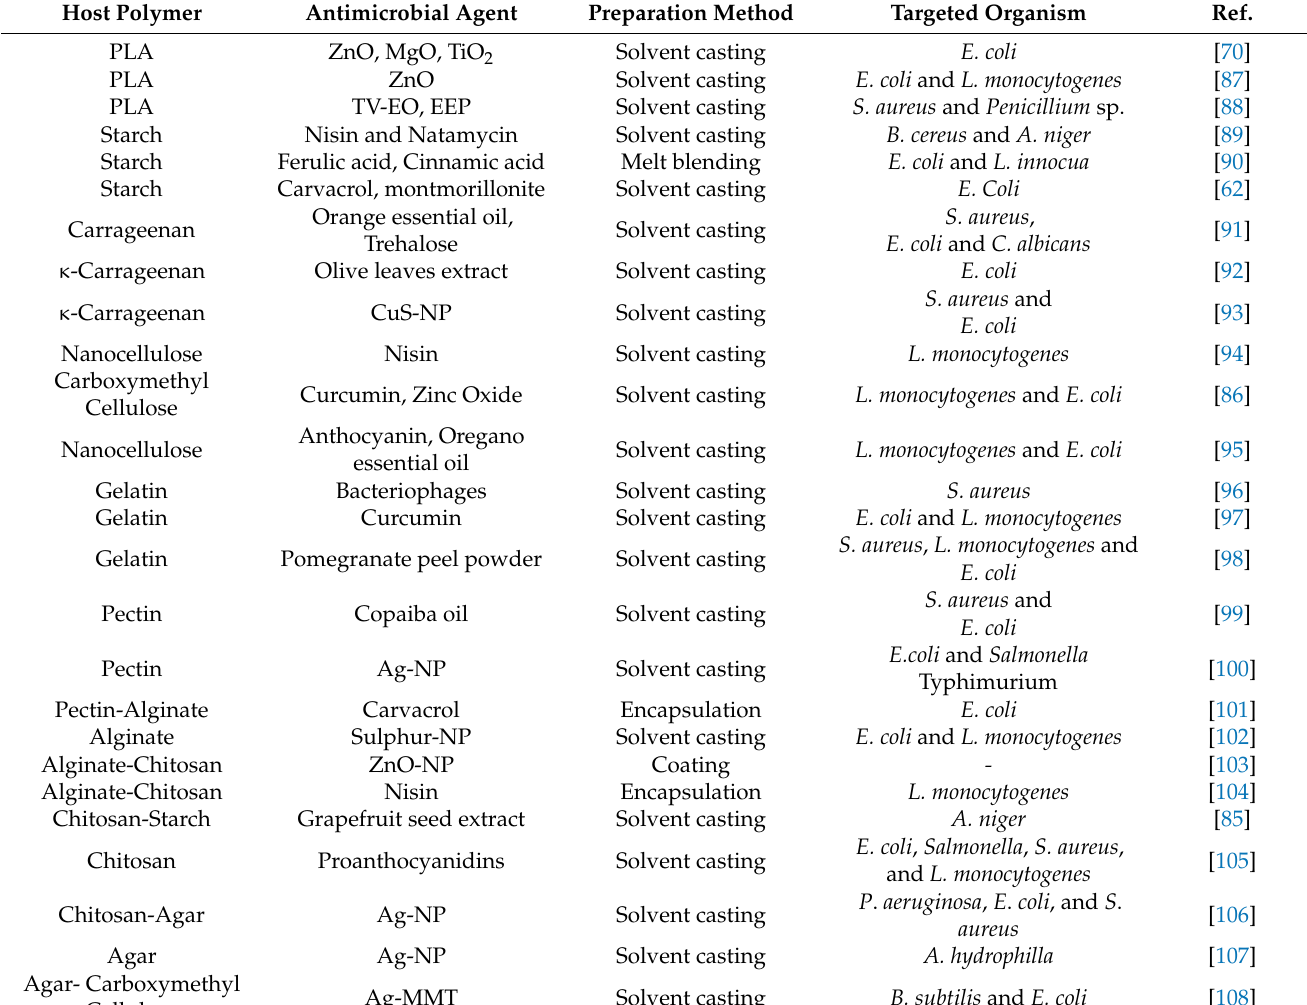
Table 2. Antimicrobial packaging systems utilizing bio-based